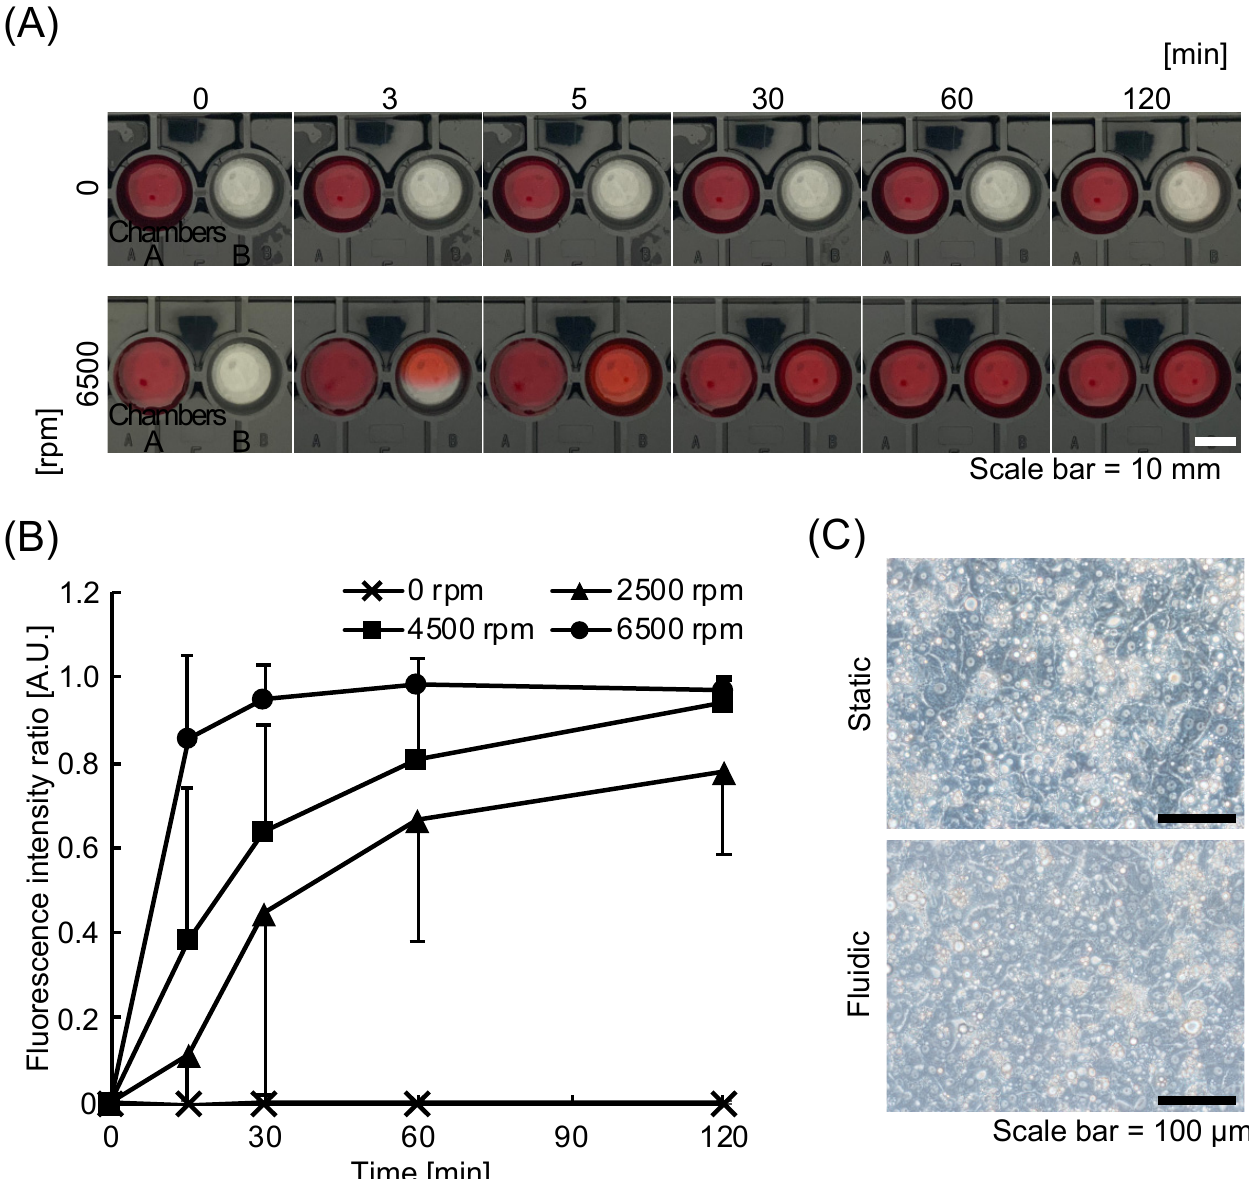
Figure 3. Evaluation of a stirrer-based kinetic pump on the kinetic pump integrated microfluidic plate (KIM-plate). ( A ) Comparison of chemical transportation with/without stirrer bar rotation of the kinetic pump in the KIM-plate. The red dye diffused from chamber A to chamber B by the rotation of the kinetic pump. ( B ) Time-dependent change in the fluorescence intensity ratio (chamber B/chamber A) of Lucifer yellow applied into chamber A. Transportation was accelerated by increasing the rotation speed of the stirrer bar. Each datum represents the mean ± SD ( n = 7–13). ( C ) Photographs of PXB cells in static/fluidic conditions. No difference in PXB cell number or morphology was observed between the nonperfusion and perfusion cultures.